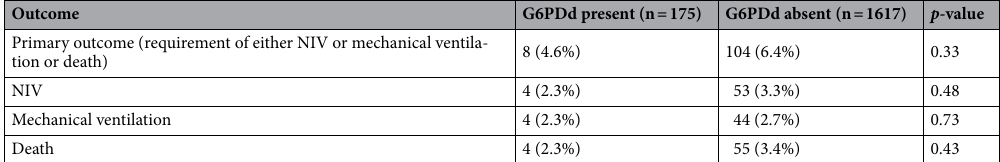
Table 4. Occurrence of primary outcome in G6PDd and non-G6PDd patients. NIV non-invasive ventilation.